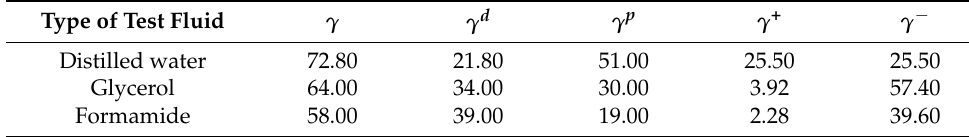
Table 7. Surface energy and parameters of test solution (mJ/m 2